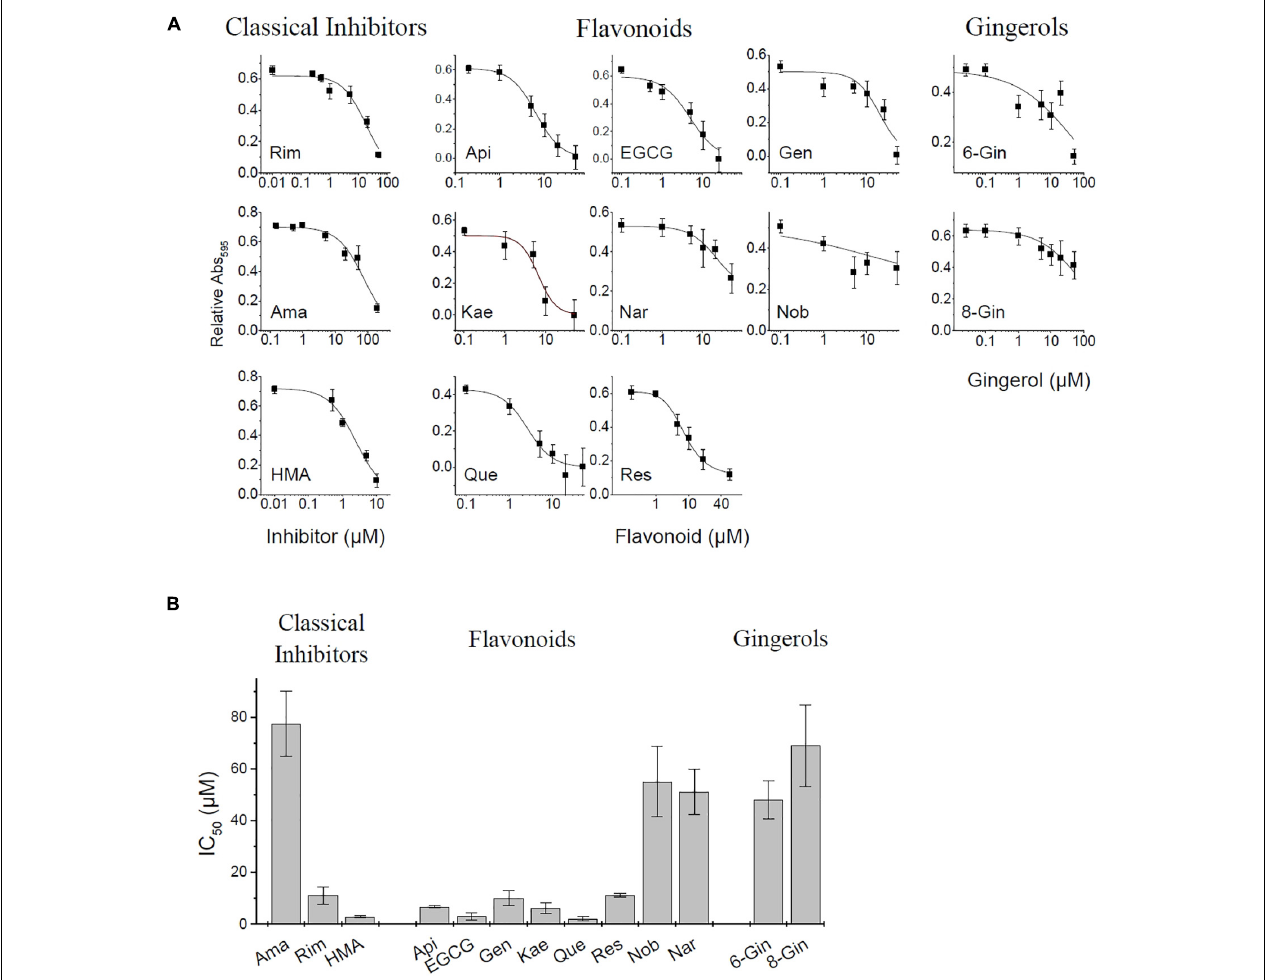
FIGURE 3 | MTT Cell viability assay for E protein activity. (A) Normalized absorbance at different inhibitor concentration. See Supplementary Figure 1 for more detail on pRK control and E protein data used for analysis. (B) Estimated IC 50 values of investigated inhibitors (means ±